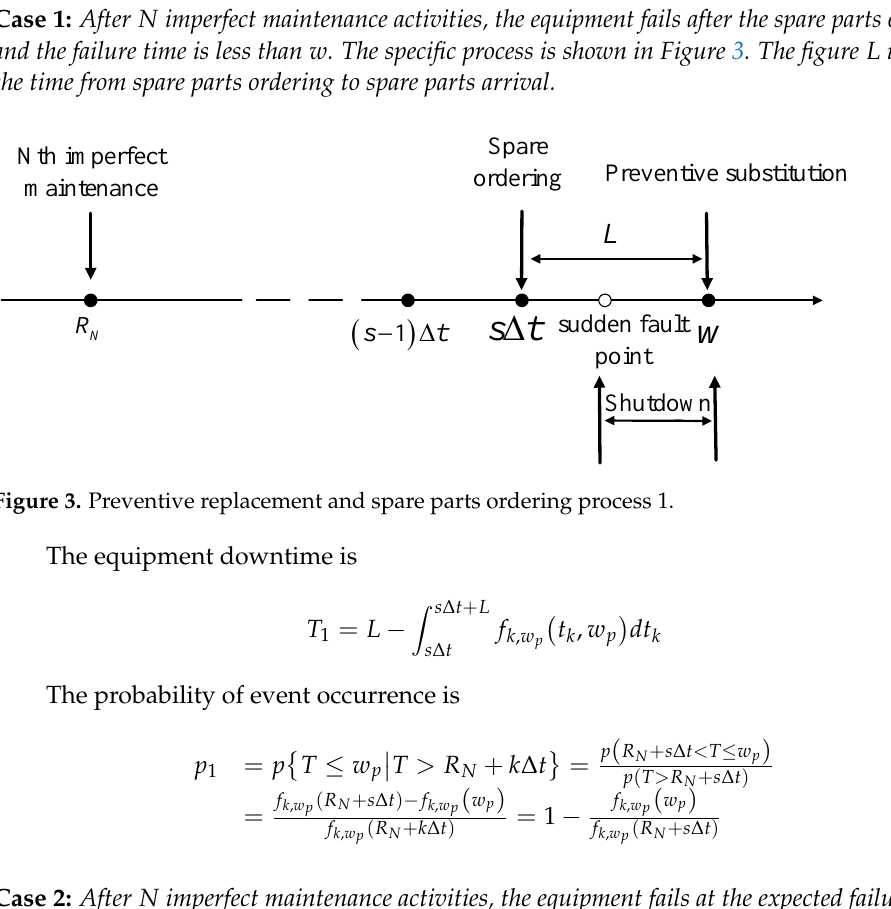
Figure 4. Preventive replacement and spare parts ordering process 2.